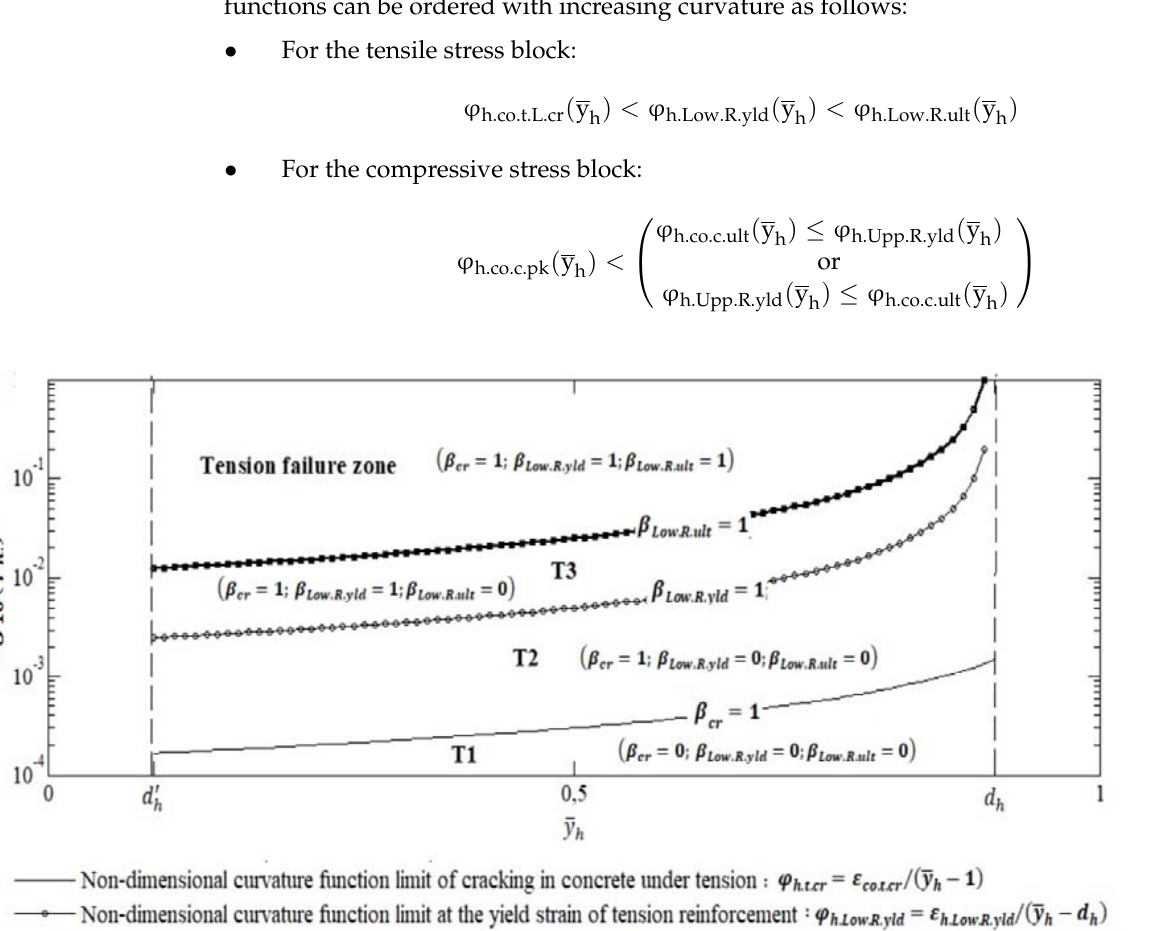
Figure 11. Curvature limits for the tension stress block.